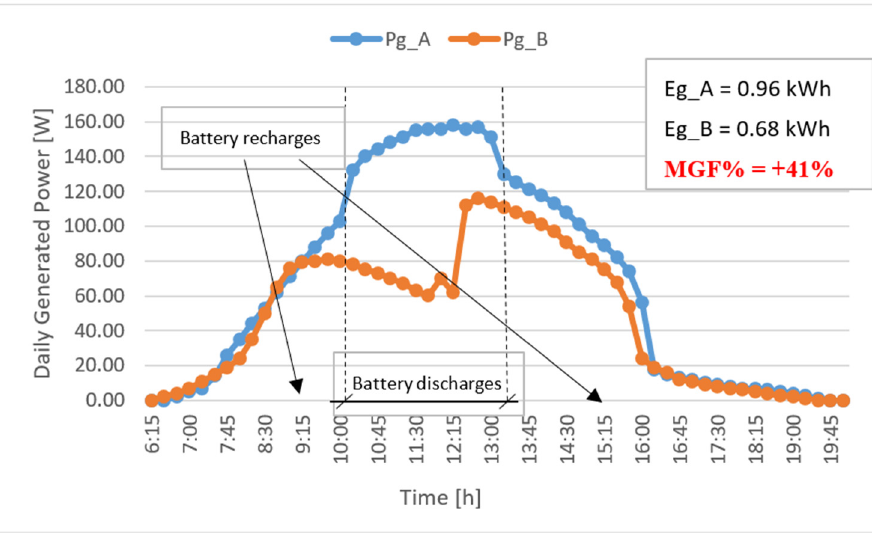
Figure 13. Daily Power generation curves, Pg_A and Pg_B, of the two prototypal PV generators A and B on an August 2021 cloudless day, together with the corresponding daily generated energy values, Eg_A and Eg_B, and the percentage major generation factor, MGF%. In this experiment, two identical shading plywood sheets have been mounted on three PV cells of both the homemade submodules of the PV generator A and B. On the submodule of the PV generator A the battery